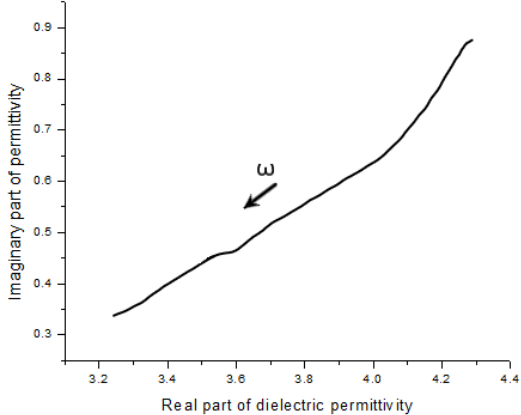
Figure 11. Cole – Cole curve of the polymer specimen. Figure 11. Cole–Cole curve of the polymer specimen.